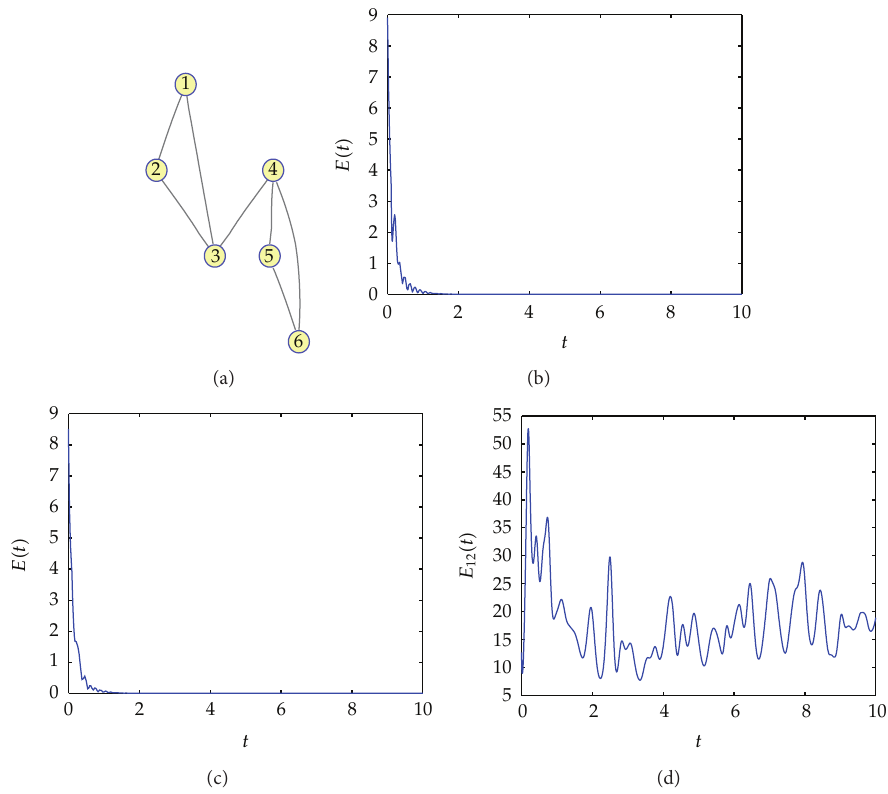
Figure 1: A network with size 𝑁 = 6 and two clusters shown in (a). (b, c) stand for the cluster synchronization error 𝐸(𝑡) in each cluster and (d) represents the error 𝐸 12 (𝑡) between the two